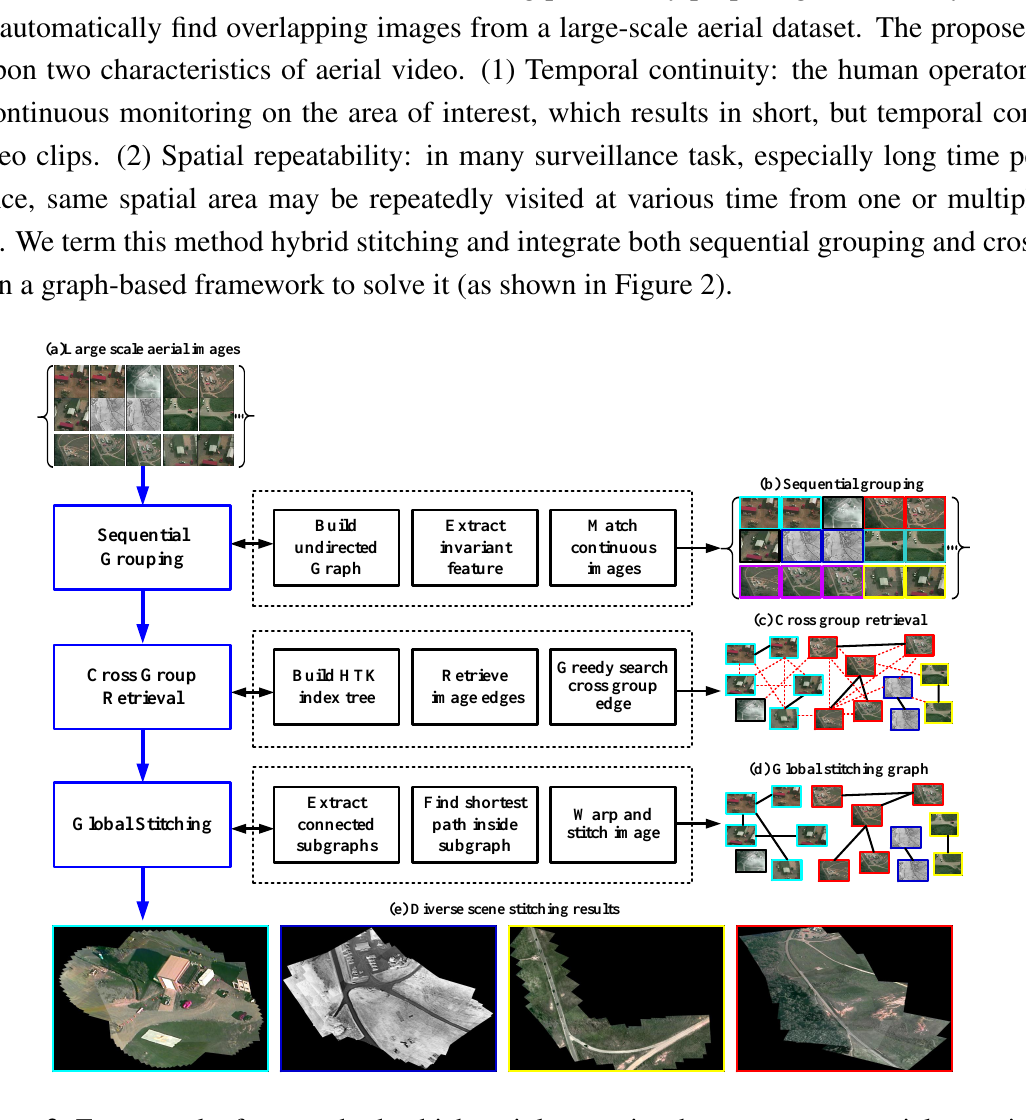
Figure 2. Framework of our method, which mainly contains three parts: sequential grouping, cross-group retrieval and global stitching. ( a ) Input large-scale aerial images; ( b ) example results of sequential grouping; the same color represents the same group; ( c ) example results of cross-group retrieval; black lines denote the sequential edges, and red dotted lines represent the candidate edges generated by retrieval; ( d ) example results of global stitching graph; black lines denote the final edges after optimization; ( e ) example results of diverse scene